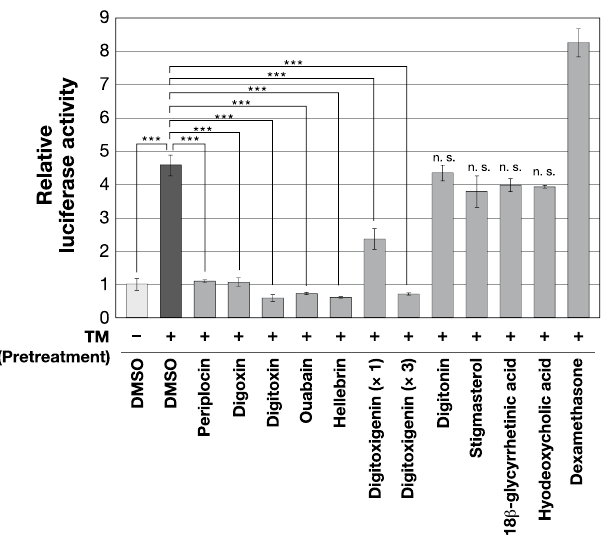
Figure 3. Various cardiac glycosides exert suppressive effects on UPR. HEK293 cells, stably expressing both XBP1us-luc2 and XBP1s-GFP , were pretreated with cardiac glycosides (0.2 µM): periplocin, digoxin, digitoxin, ouabain, and hellebrin, or an aglycone (× 1: 0.2 µM, × 3: 0.6 µM): digitoxigenin, or the other compounds that have a steroidal back bone, but do not exhibit cardiotonic activity (0.2 µM): digitonin, stigmasterol, 18 β -glycyrrhetinic acid, hyodeoxycholic acid, and dexamethasone, for 1 h and were then incubated with TM (0.5 µg/ml). DMSO was added as vehicle. After 6 h, luciferase activities and fluorescence intensities in cell lysates were measured. Luciferase activity was normalized by fluorescence intensity. Values shown are mean fold activity ± S.D. ( n = 3 biological replicates). Significant differences are indicated as *** p < 0.001, assessed by one- way ANOVA with Dunnett’s post-test; n. s., not